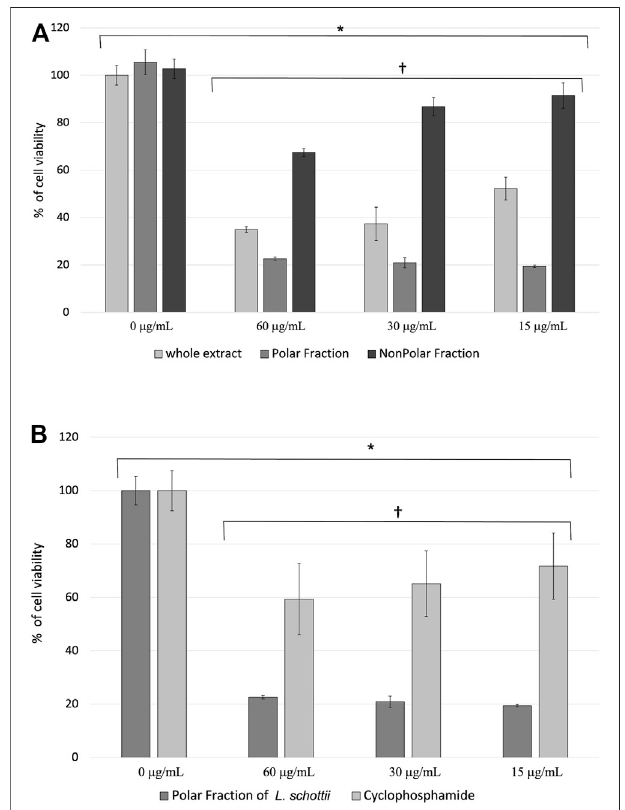
FIGURE 1 | (A) Percentage of cell viability ± standard error of murine lymphoma L5178Y cells treated with the ethanolic extract and polar and nonpolar fractions of Lophocereus schottii (µg/mL). Values are the average of % cell viability. * p < 7.3 X 10 − 8 . † p < 1.7 X 10 − 15 . (B) Percentage of cell viability ± standard error of murine lymphoma L5178Y cells treated with the polar fraction of the ethanolic extract of Lophocereus schottii (PFLs) and cyclophosphamide(µg/mL).Valuesaretheaverageofthe%ofcellviability.*p < 4.4 x 10 − 4 . † p < 5.8 X 10 − 10